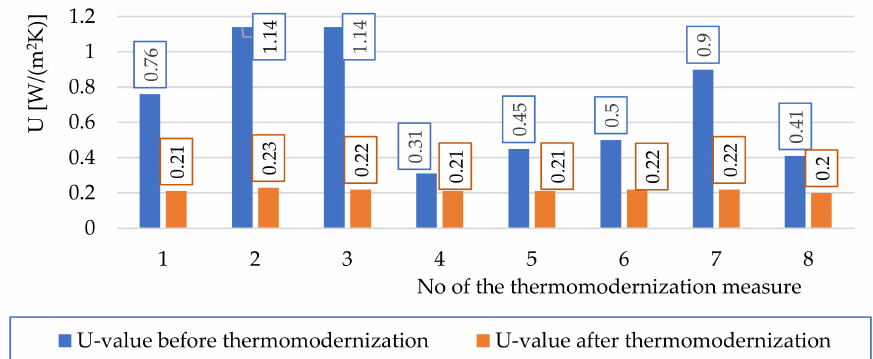
Figure 9. Calculated values of thermal transmittance coefficients before and after thermomoderniza- tion of the tested object for individual parts of the building envelope: 1—façade, 2—external walls of staircases, 3—external walls of basement, 4—roof, 5—roof over the staircases, 6—roof over the auditorium, 7—ceilings in loggias and recesses (above the basement), 8—ceiling under the outer ceiling of the auditorium and over the recesses at the entrances.